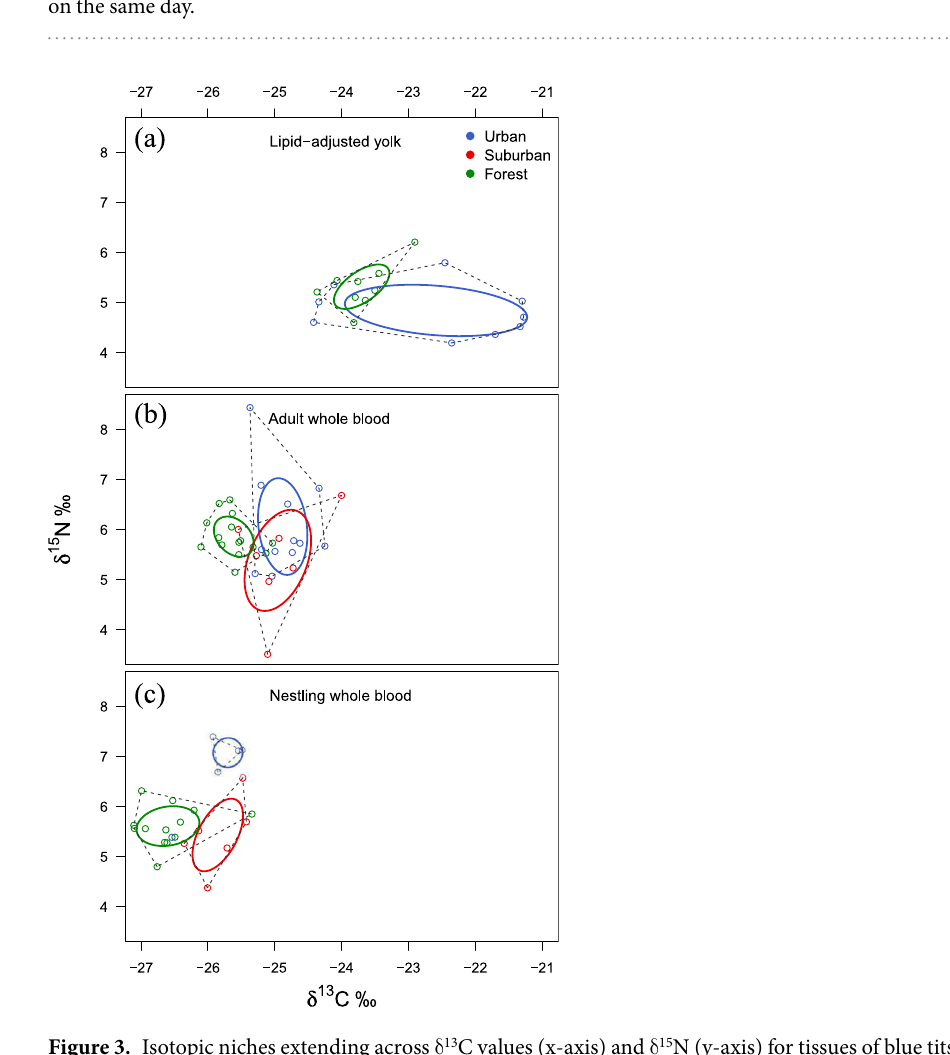
Figure 3. Isotopic niches extending across δ 13 C values (x-axis) and δ 15 N (y-axis) for tissues of blue tits from different sites. Isotopic niches for ( a ) yolk obtained from blue tit eggs, and for whole blood samples of ( b ) adults and ( c ) nestlings from the three study sites. Each dot represents one egg ( a ), one adult blood sample ( b ), and one blood sample pooled from 2–4 nestling siblings ( c ). The broken line represents total convex hull, and the solid ovals are ellipses that include approximately 40% of individuals within a group, which represents the breadth of the isotopic niche in each